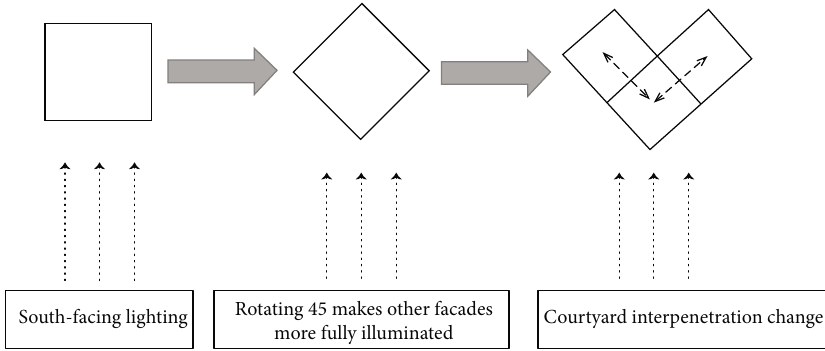
Figure 2: The building layout of the improved cold area.